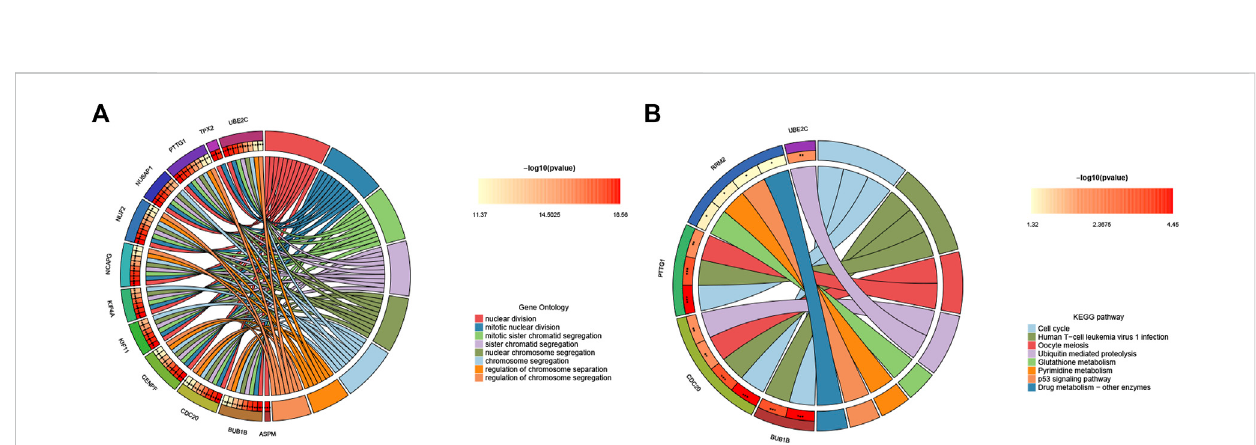
FIGURE 5 Functional enrichment analysis of hub genes. (A) Circle diagram visualization of GO terms, and (B) top eight signi fi cant KEGG pathways. For each graph, the right semicircle represents signi fi cant pathways. Different color modules represent different pathways. And the left semicircle represents the genes enriched in the same color